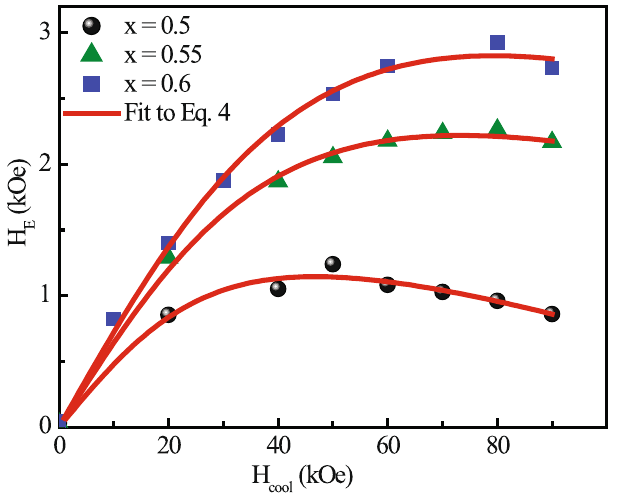
Figure 8. Variation of H E with cooling magnetic field. Red lines represent the fitting using relation 4 for Sm 1 − x Ca x MnO 3 (x = 0.5, 0.55 and 0.6) bulk